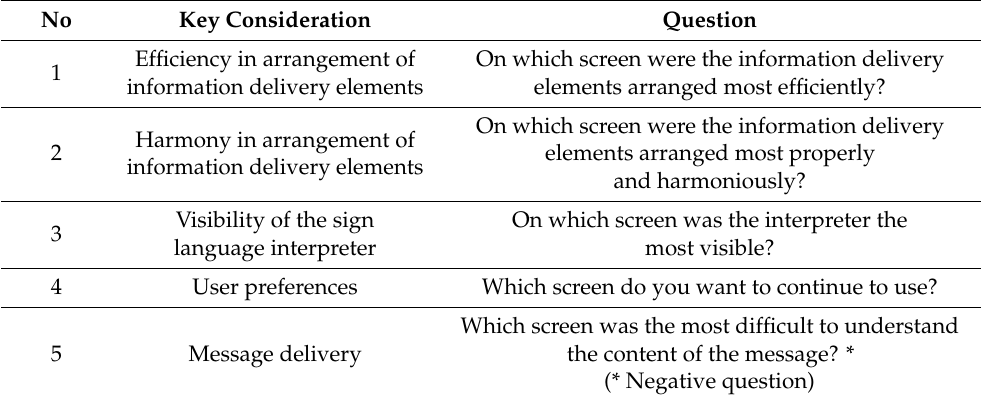
Table 5. Questions for preference evaluation of the screen layout